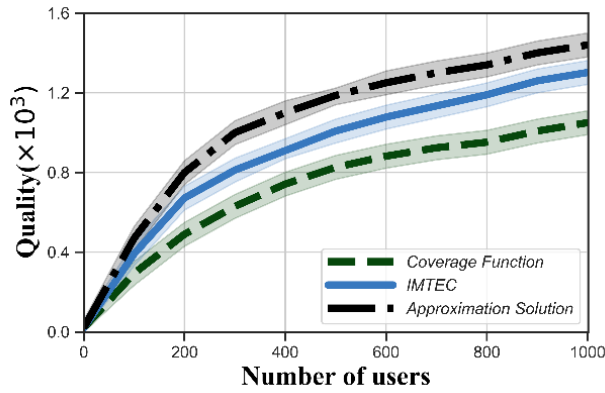
Figure 7. Quality function versus the number of users.